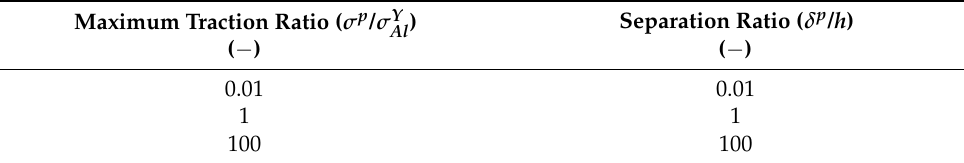
( b ) ( c ) Figure 9. Engineering stress versus engineering strain for ( a ) 𝛿 (cid:3043) /ℎ = 0.01 , ( b ) 𝛿 (cid:3043) /ℎ = 1 and ( c ) 𝛿 (cid:3043) /ℎ = 100 . 4. Closing Remarks This research concerns material systems made of thin metal foils and polymer ply coupling. In the present work, computational approaches were employed to investigate the mechanical behavior of thin laminated structures, considering a kind of imperfection